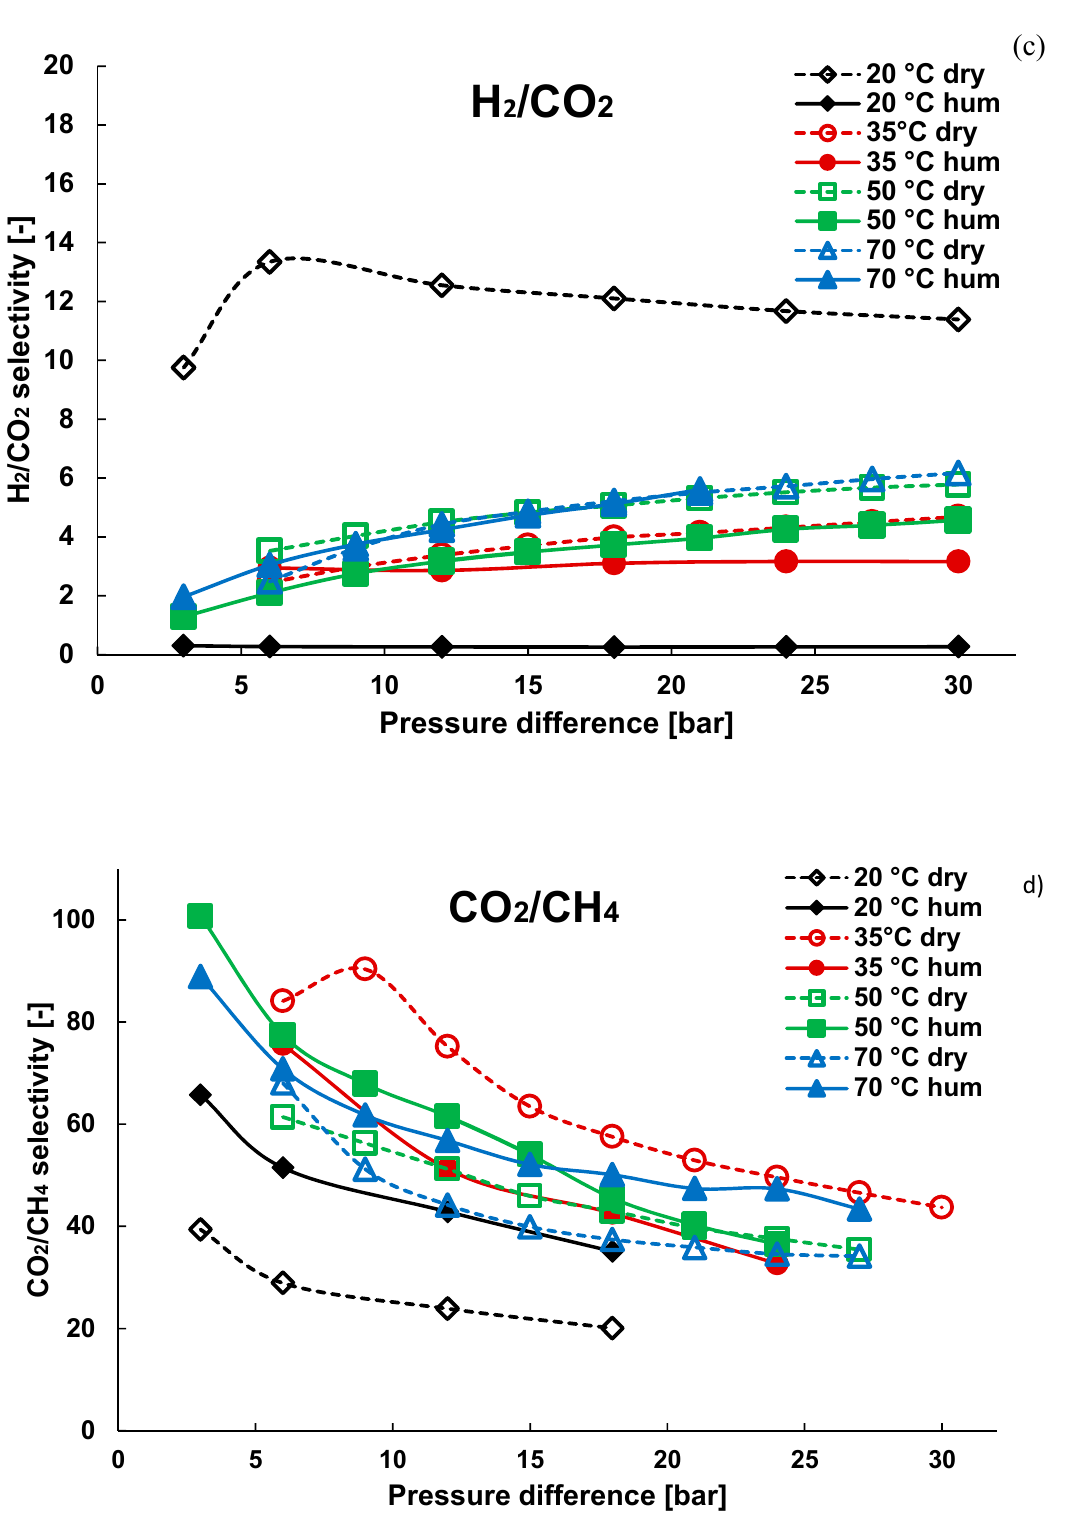
Figure 8. ( a ) H 2 /CH 4 , ( b ) H 2 /N 2 , ( c ) H 2 /CO 2 ( d ) CO 2 /CH 4 selectivity at high pressure from 20 to 70 °C with a dry and humidified stream.